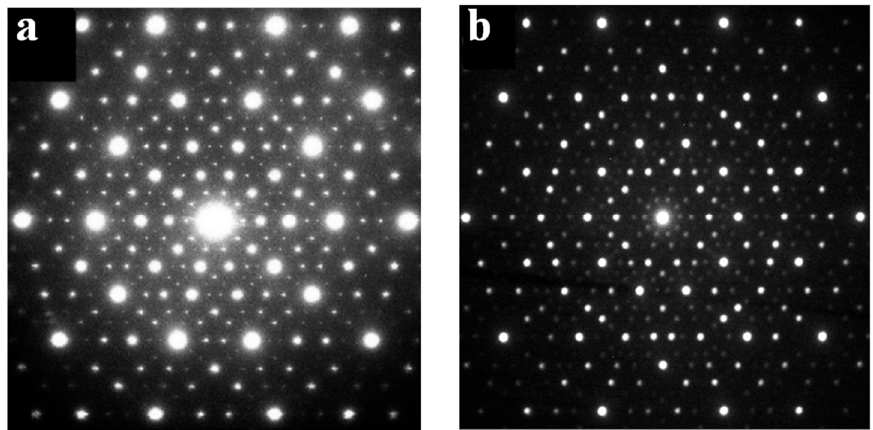
Figure 8. Electron diffraction patterns of quasicrystals found in the Khatyrka meteorite. ( a ) icosahedrite [11] and ( b ) quasicrystal with decagonal symmetry